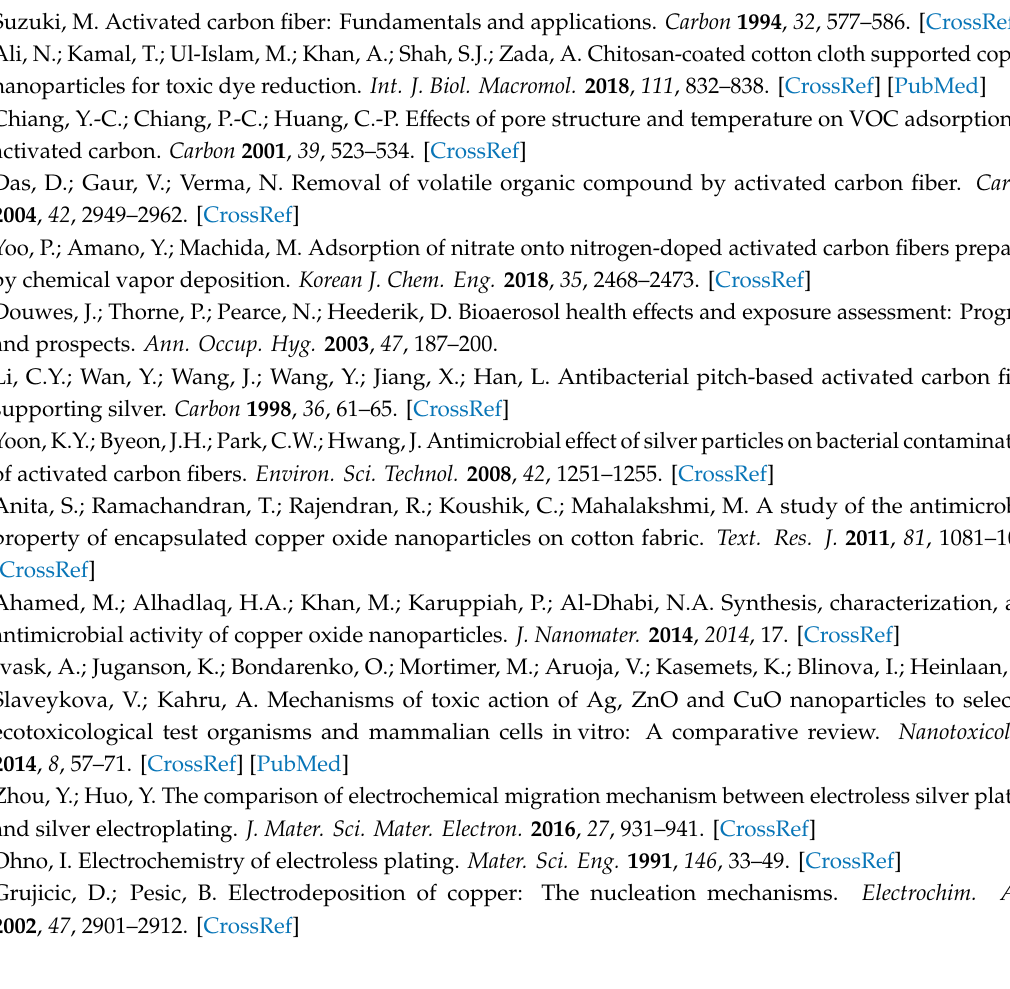
Figure S1: SEM images of ACF@PD at (a) low and (b) high magnification; Figure S2: Cu content of ACF@PD-CuO with di ff erent coating times obtained from EDS analysis; Figure S3: SEM images of ACF@PD-CuO-12h with (a) low- and (b) high-magnification and pristine ACF with (c) low- and (d) high-magnification to measure the precise coating thickness of PD-CuO; Figure S4: SEM images of (a) ACF@PD-CuO-4h and (b) ACF@PD-CuO-8h for measuring the coating thickness of PD-CuO; Figure S5: TEM images of ACF@PD-CuO-12h at (a) low and (b) high magnification; Figure S6: Ex-situ SEM images for ACF@PD-CuO (a) before the and after the antimicrobial test and washing: (b) E-coli and (c) S-aureus